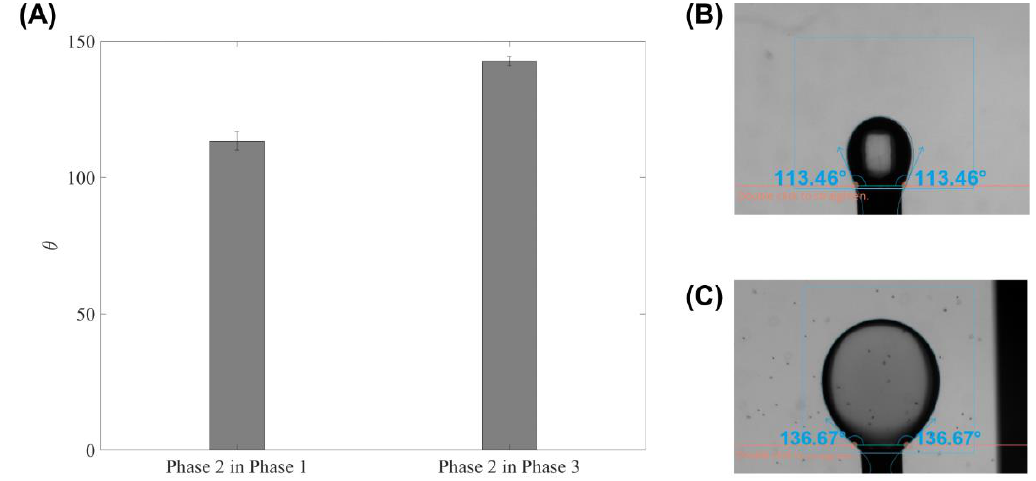
Figure 2. The interfacial tension coefficients measurement: ( A ) the mean contact angles (error bars represent the standard deviations and n = 7); ( B ) middle-phase reversed pendant drop in inner phase; ( C ) Middle phase reversed pendant drop in outer phase.